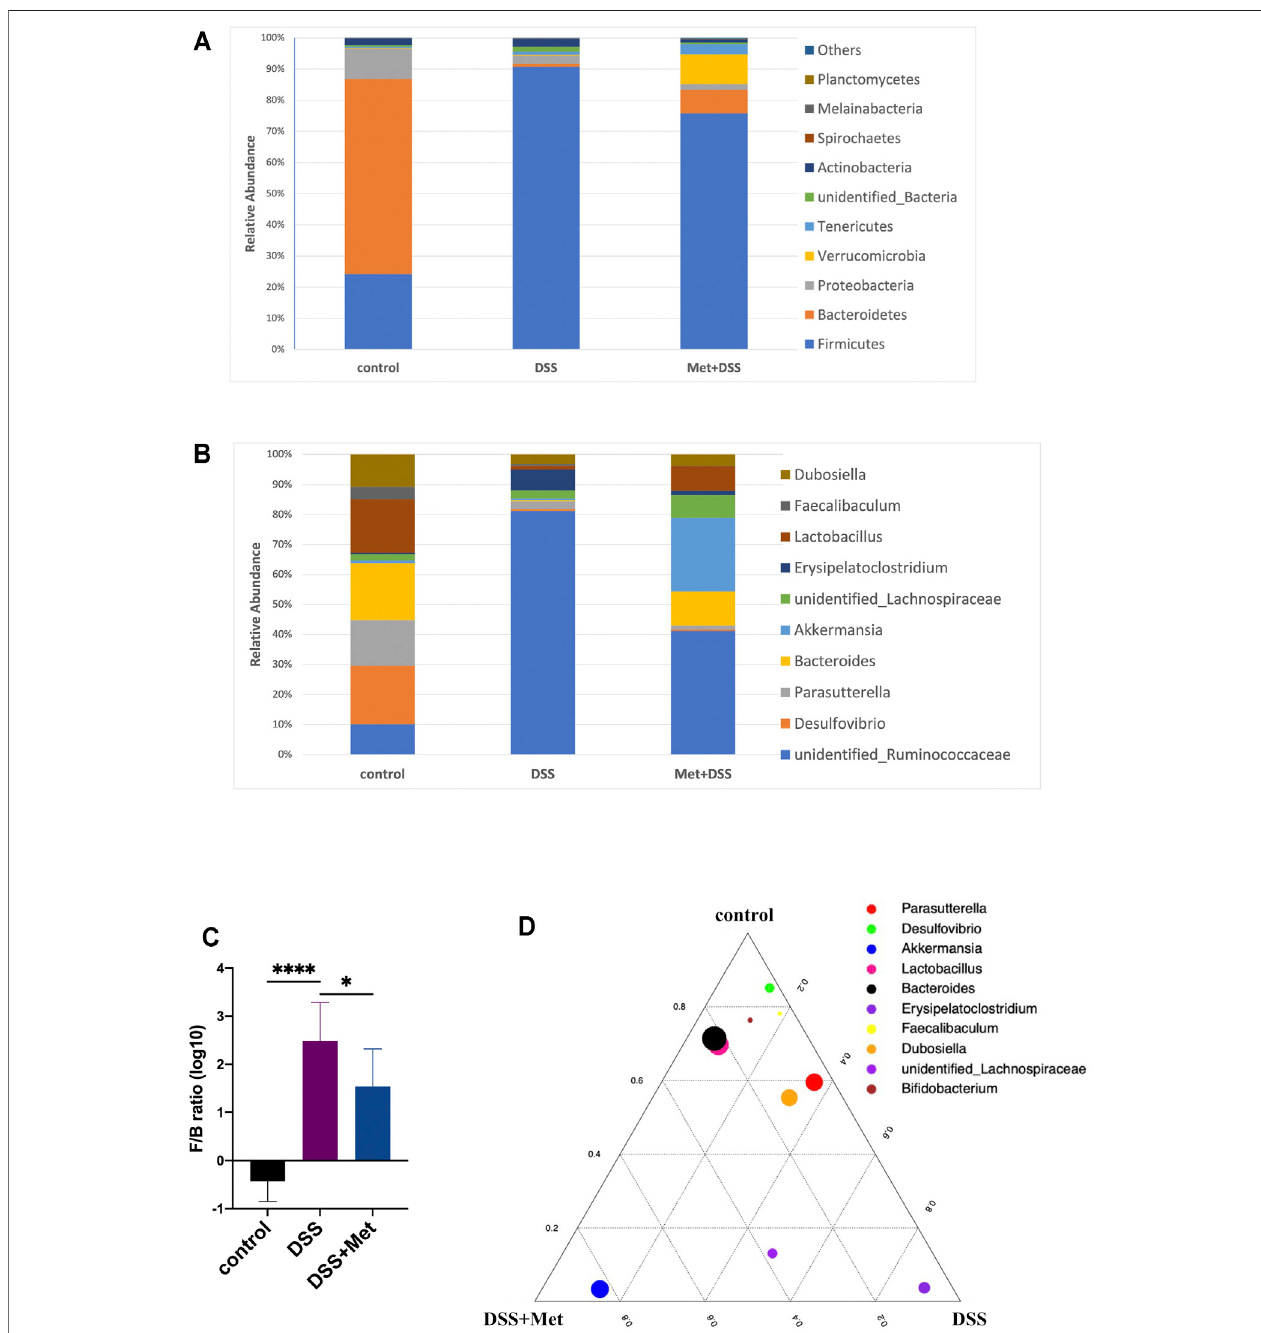
FIGURE 4 | Metformin changes the structure of the gut microbiota ( n (cid:1) 4 – 10). Fecal 16S rRNA sequencing of gut microbiota of the metformin, dextran sulfate sodium (DSS) and control group. Relative abundance (% of the total community) of 10 most abundant phyla (A) and 10 most abundant genera (B) , Firmicutes/ Bacteroidetes (F/B) ratio (log10 transformation) (C) and ternary plot indicating the fraction of 10 most abundant genera in the metformin group (bottom left corner), dextran sulfate sodium (DSS) group (bottom right corner) and control group (top corner) with the size of each dot representing the relative abundance (D) .